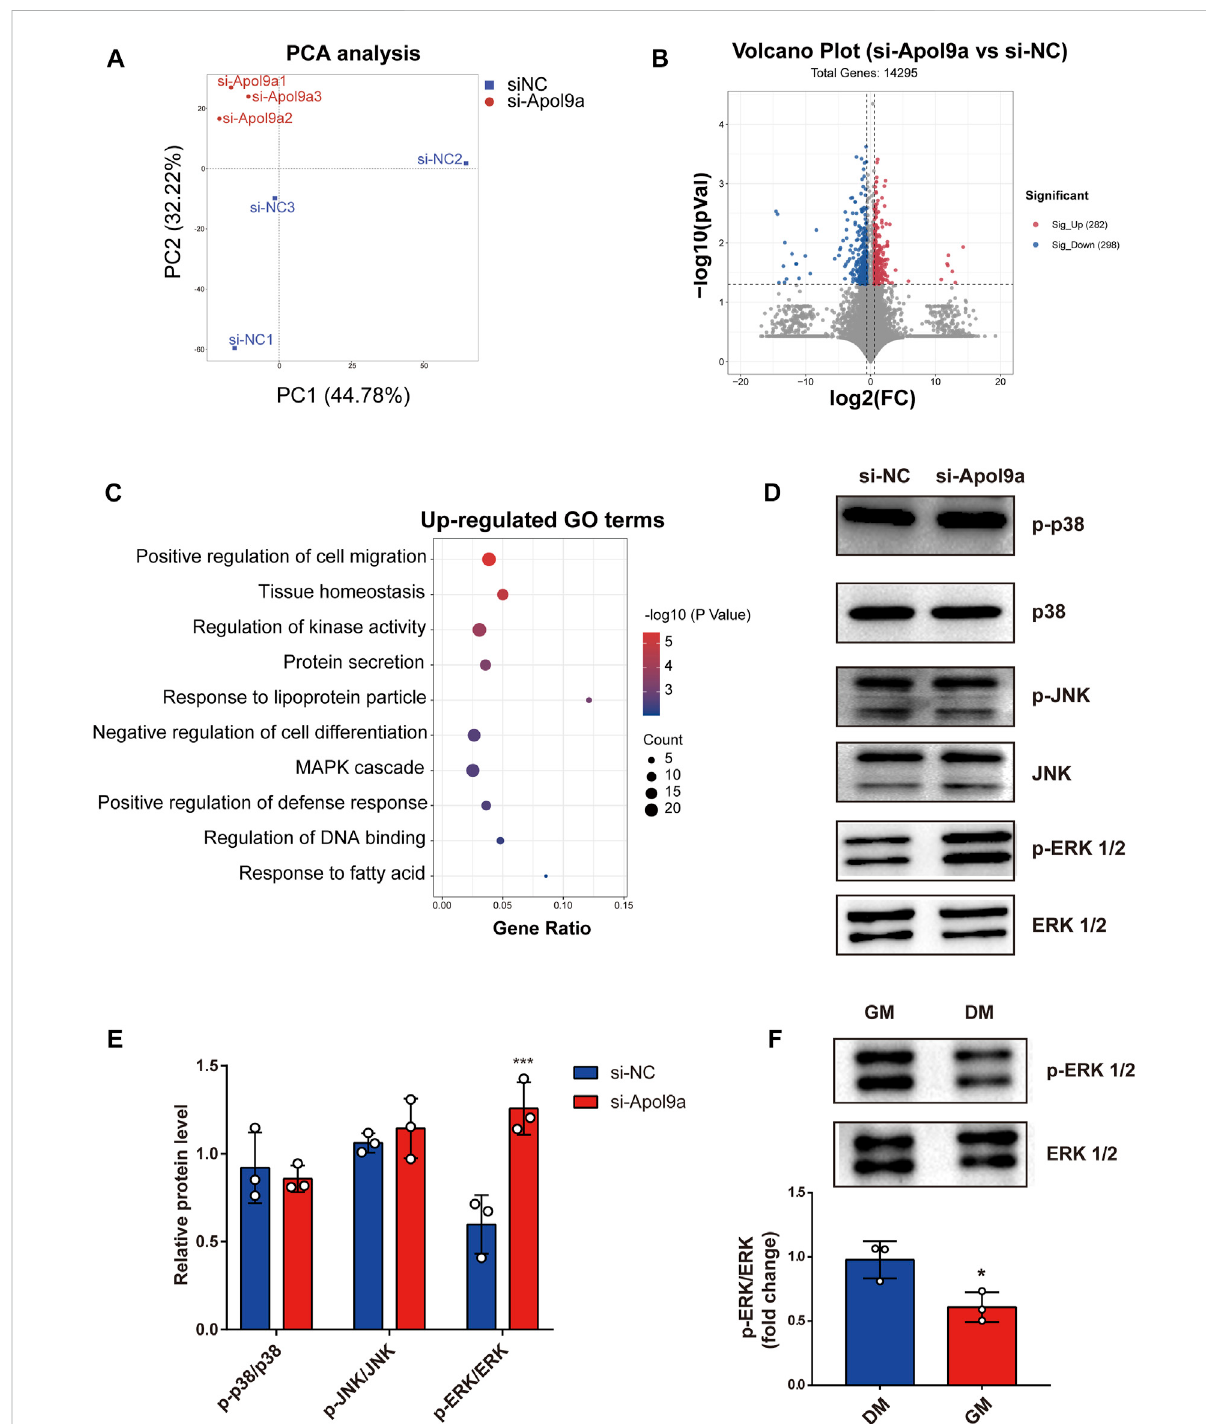
FIGURE 6 Transcriptomic data. C2C12 cells with or without si- Apol9a treatment was harvested after myogenic differentiation, and then transcriptomic analysis was performed. (A) Principal component analysis of RNA-seq data from C2C12 cells with (si- Apol9a ) or without (si-NC) Apol9a knockdown after myogenic differentiation ( n = 3 per group). (B) Volcano plot showing the DEGs in C2C12 cells with (si- Apol9a ) or without (si-NC) Apol9a knockdownaftermyogenicdifferentiation. (C) GeneontologyanalysisofupregulatedDEGs. (D) Westernblotanalysisshowedtheproteinlevels of p-P38, P38, p-JNK, JNK, p-ERK1/2, and ERK1/2. (E) Gray scale analysis of western blot results determined using ImageJ software. (F) Westernblot analysis for p-ERK1/2 and ERK1/2. C2C12 cells were cultured in GM or DM for 4 days. The data are expressed as mean ± SEM. * p < 0.05, ** p < 0.01, *** p < 0.001 vs. si-NC